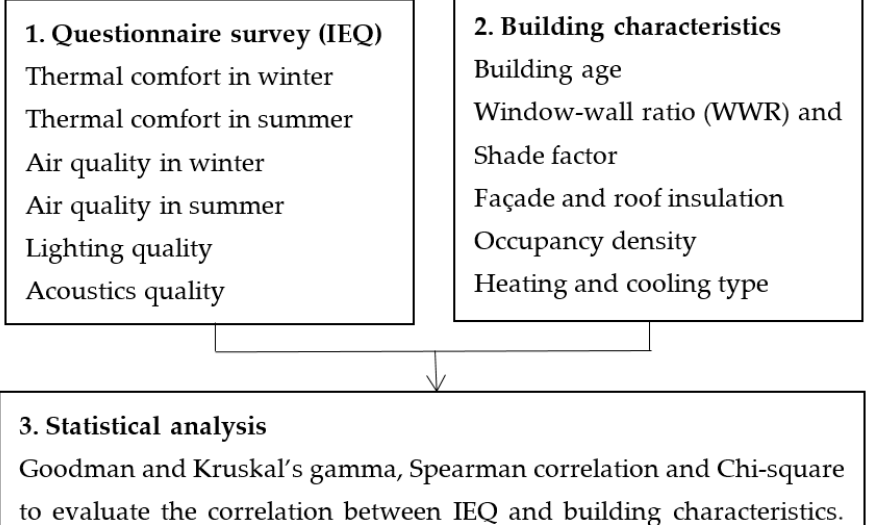
Figure 1. Study methodology.